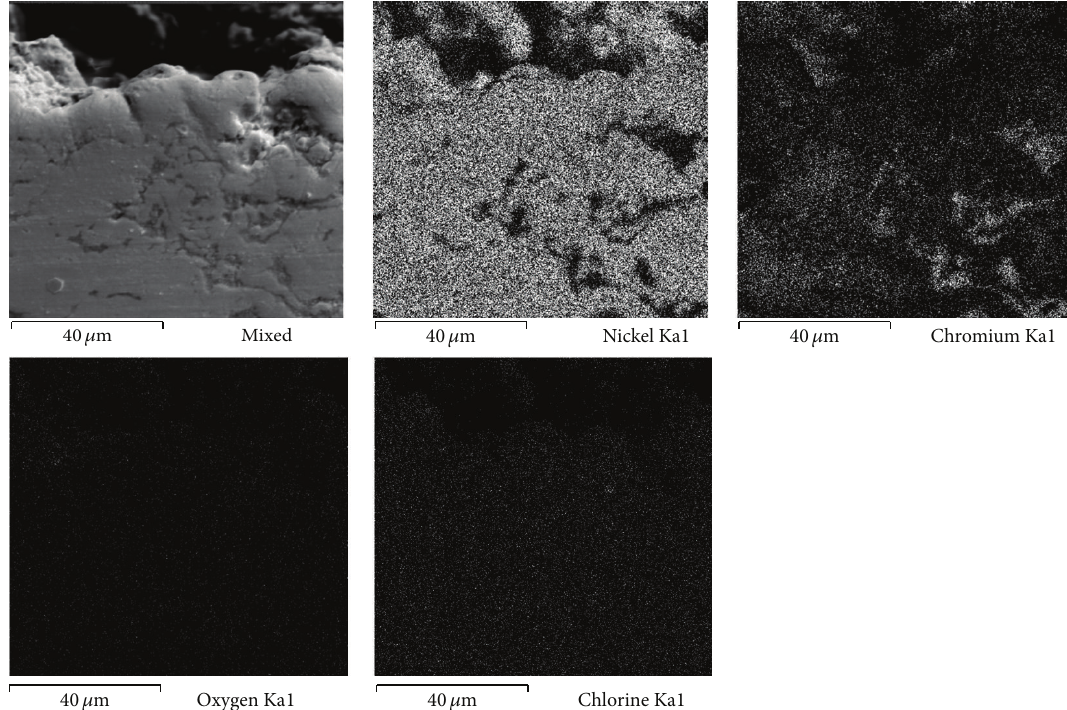
Figure 9: Cross-sectional aspect of the Ni20Cr as-deposited coating and elements distribution after corrosion test at 450 ∘